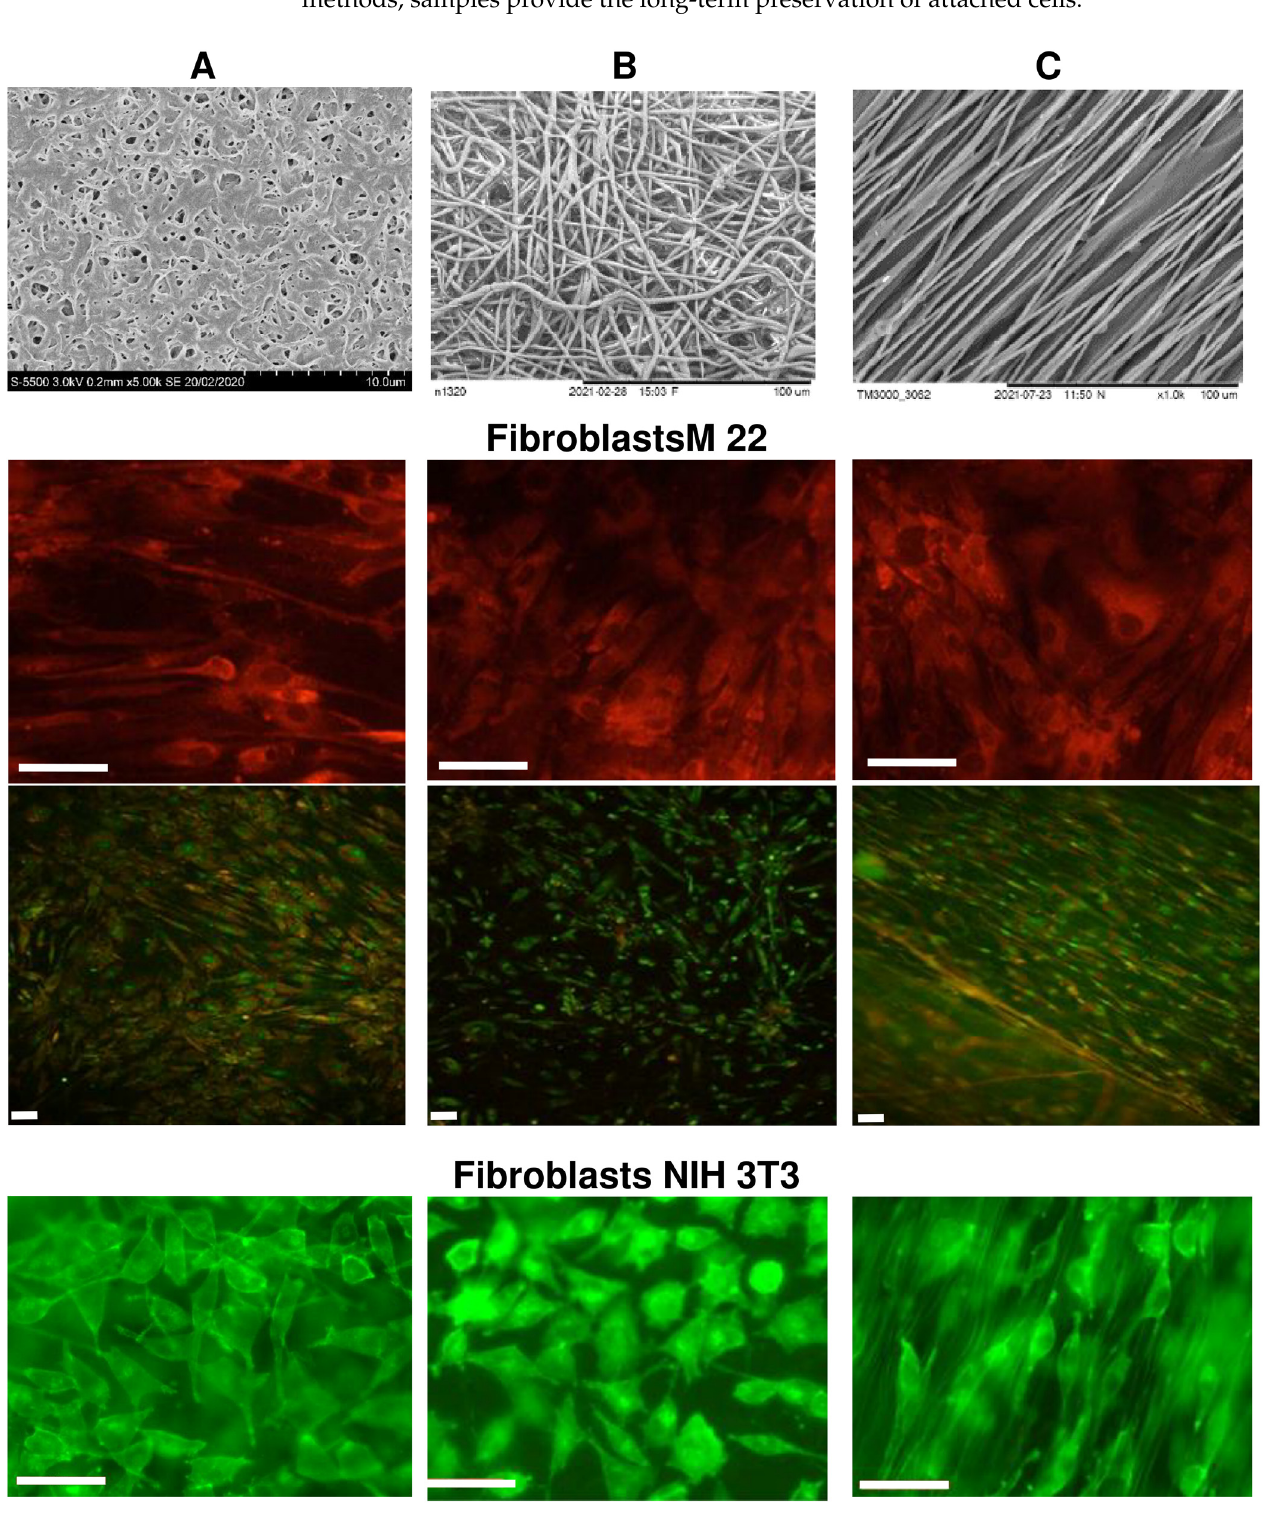
Figure 6. Fibroblasts cultivated on P(3HB-co-4HB) polymer carriers: ( A )—solvent-cast film; ( B )—random nanomembranes; ( C )—aligned nanomembranes. Supravital staining with fluorochrome stains: fibroblasts M22 tripaflavin and rhodamine C; fibroblasts NIH 3T3-FITC; bar 50 μ m. Nonwoven membranes obtained by the method of electrostatic molding of polymer solutions, as noted above, had differences in structure and physical and mechanical properties. The nonwoven membranes had contact angles (on the order of 51–68°) that were much lower than those of the solvent-cast films (up to 92°). This was accompanied